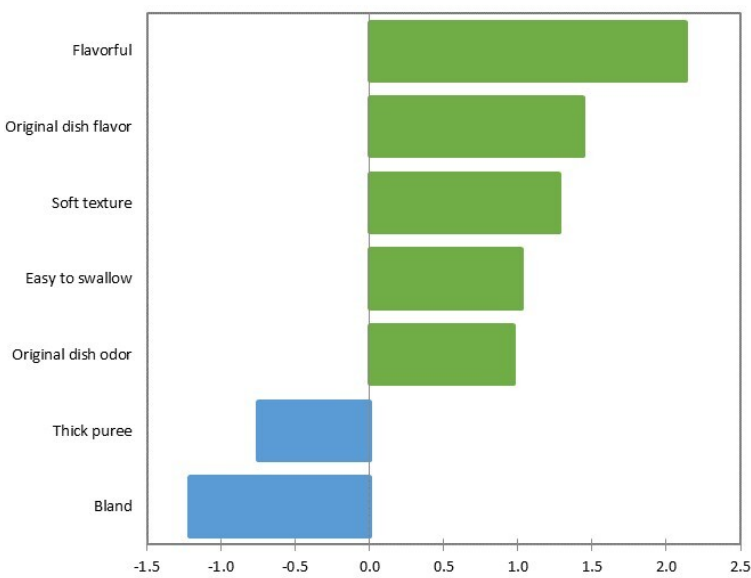
Figure 3. Effect of the CATA method attributes on judges’ hedonic evaluation about the texture- modified dishes for CP dysphagia. Mean drops vs. percentage chart to identify “must not have” and “nice to have” attributes with significant effect ( p < 0.05) on the mean.